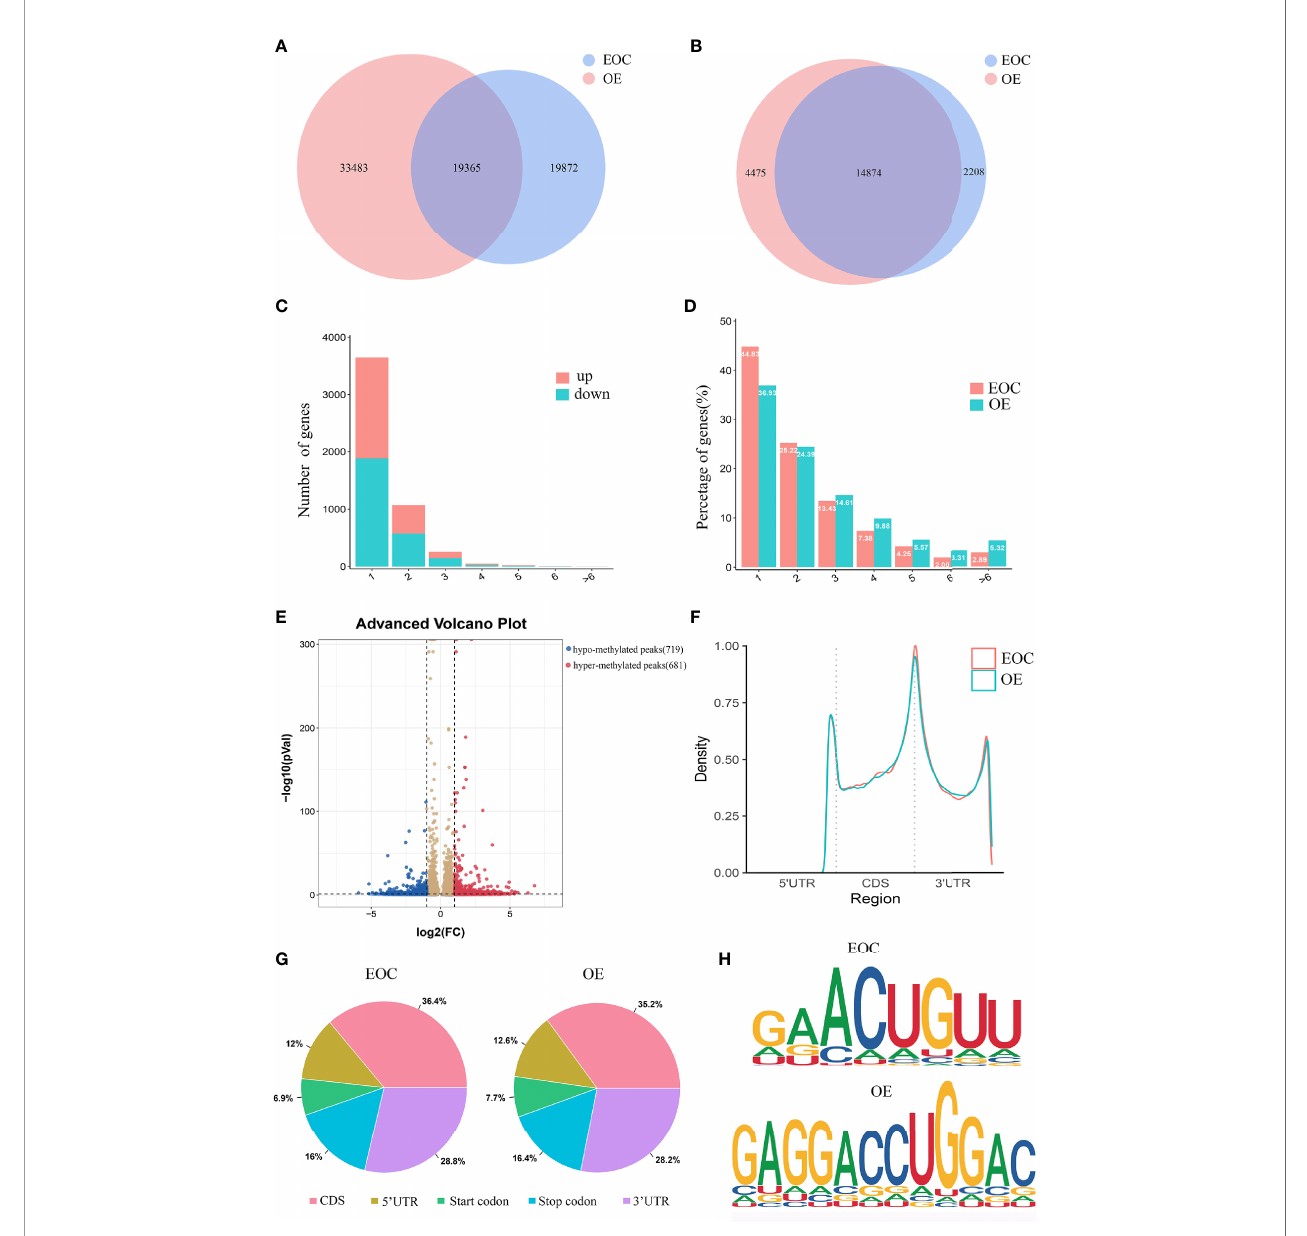
FIGURE 1 | Characteristics of m6A distributions in EOC and OE. (A) Venn diagrams of overlaps of m6A peaks and (B) genes in EOC and OE tissues. (C) The distribution of differentially modi fi ed m6A peaks with signi fi cance per gene. (D) Number of peaks per gene in EOC and OE tissues. (E) Volcano plots showing the signi fi cant differential m6A peaks in EOC samples compared with OE samples. (F) The distribution and difference in the density of m6A peaks along all the transcripts in EOC and OE. (G) Pie charts showing the distributions of m6A peaks in EOC and OE tissues. (H) Representative m6A motifs enriched from the altered m6A peaks in EOC and OE groups, with P -values of 1*e -166 and 1*e -247 ,